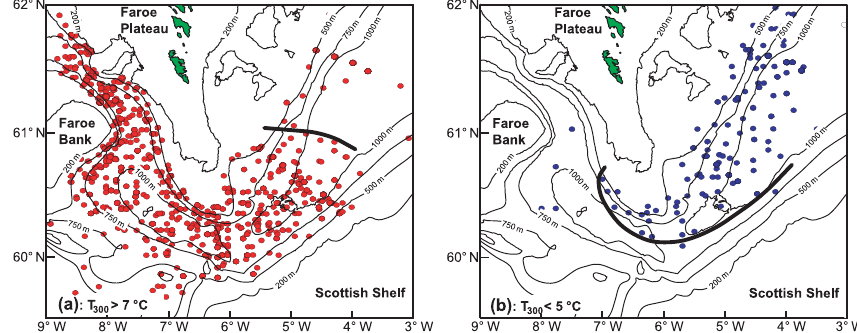
Figure 7. Temperature at 300m depth. (a) Red dots show locations with temperature at 300m depth higher than 7 ◦ C. Black curve indicates the approximated eastern border. (b) Blue dots show locations with temperature at 300m depth lower than 5 ◦ C. Black curve indicates the approximated western border. Based on 2905 CTD profiles obtained by RV Jens Christian Svabo or by RV Magnus Heinason 1976–2015 at locations with bottom depth at least 400m in the